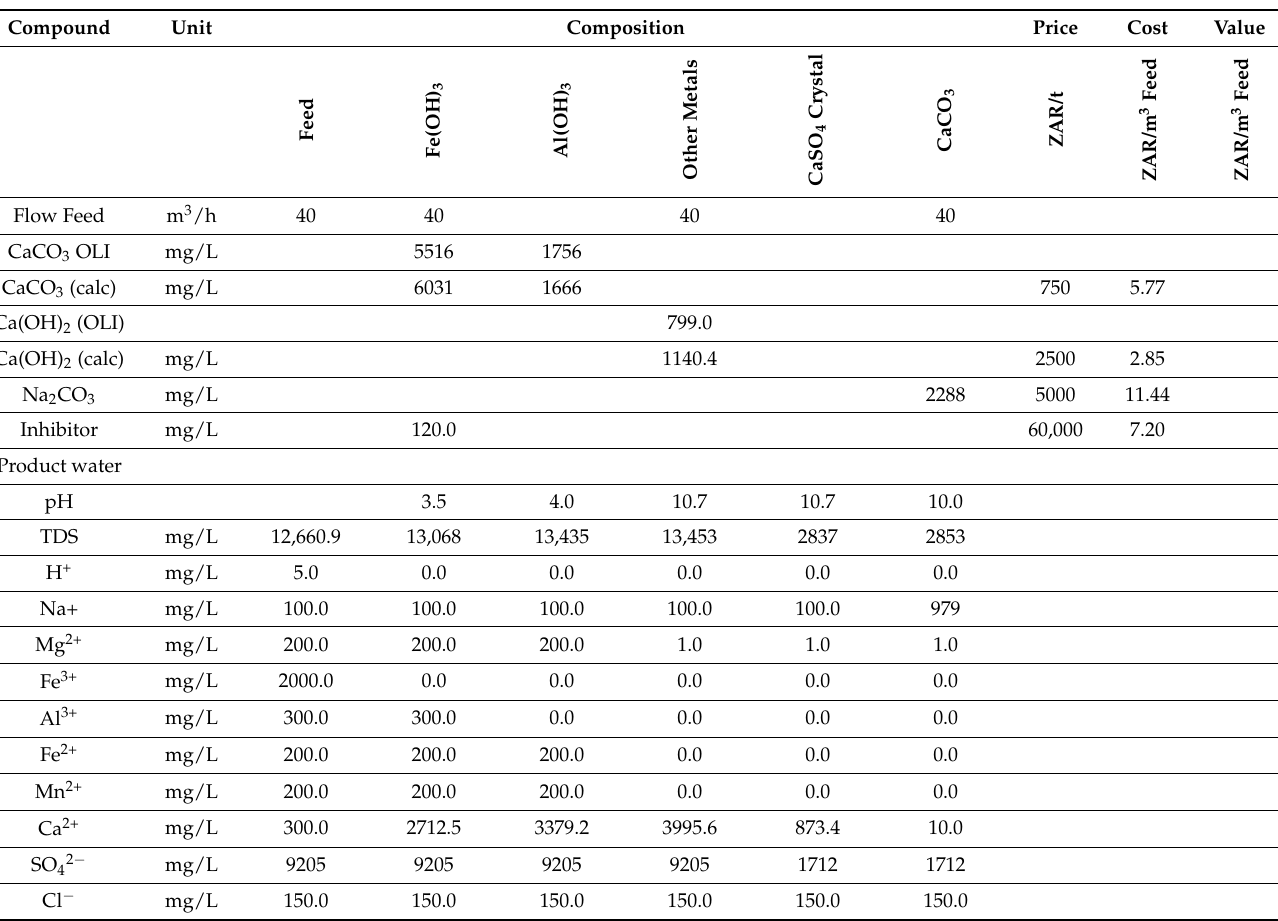
Table 11. Chemical cost and water quality when acid mine water is treated with CaCO 3 for removal of Fe 3+ and Al 3+ , Ca(OH) 2 for the removal of Fe 2+ , Mn 2+ , and Na 2 CO 3 for the removal of Ca 2+ associated with SO 42 −